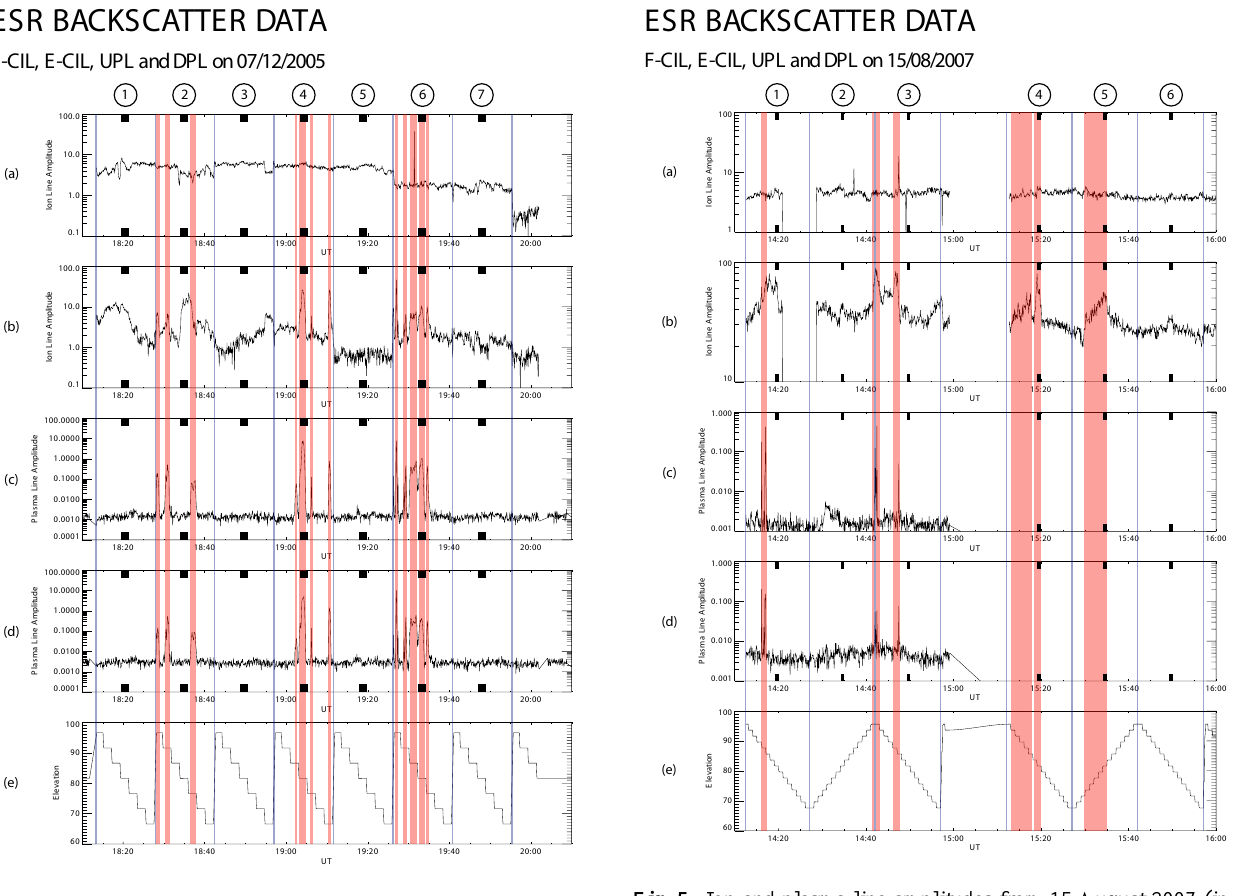
Fig. 4. Ion and plasma line amplitudes from 7 December 2005 (interval 1). Panels (a) to (d) show the F-region central ion line (150–250km), E-region central ion line (80–110km), the up- shifted plasma line and the downshifted plasma line respectively. Panel (e) shows the elevation angle (angular displacement from hor- izontal) of the 32m dish. In this figure, and in Fig. 5, the start- and end-times of the ESR scanning cycles are identified using vertical light blue lines. The periods during which the ESR pointed field- aligned are denoted using black rectangles at the top and bottom of the data panels, with each scanning cycle being labelled by the circled numbers located above the panels. The red bars, of vary- ing thickness, indicate periods of high ion or plasma line amplitude consistent with the action of SPEAR. There are clear ion and plasma line spectral enhancements from several directions, including from FA+15, FA+10, FA+5, FA, FA − 5 and FA − 15, with notable en- hancement occurring in FA. The upshifted and downshifted plasma line enhancements occur mainly in the E-region and are clearly well correlated, both with each other and with the ion line enhancements.